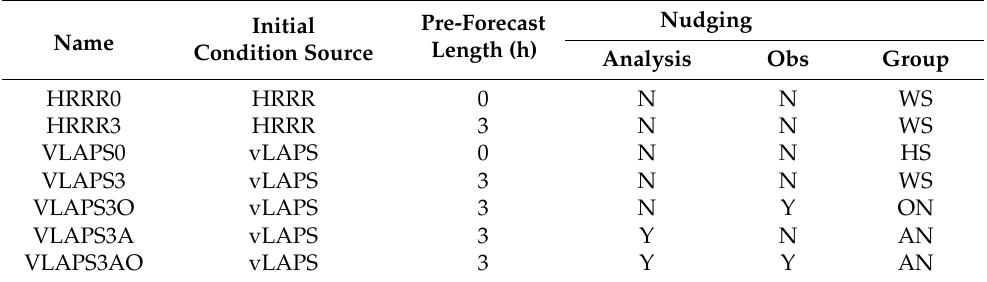
Table 1. Experimental design. Groups are HS = hot start, WS = warm start, ON = observation nudging, and AN = analysis nudging (VLAPS3AO contains both analysis and observation nudging but is assigned to group